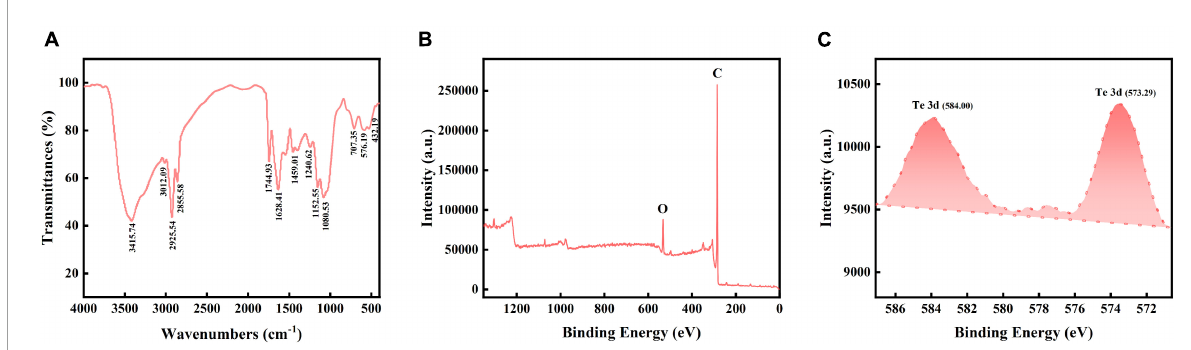
FIGURE5 FT-IR and XPS analysis of Bio-TeNPs. (A) Bio-TeNPs consisted of proteins, lipids, aromatic compounds, and carbohydrates according to the FT-IR results. Survey spectrum of Bio-TeNPs with (B) , high resolution spectrum of Te3d (C) based on XPS analysis.